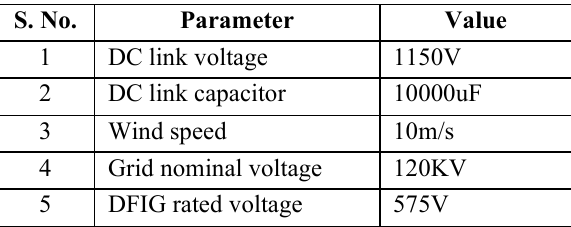
Table 3. Specifications of the DFIG system S. No.